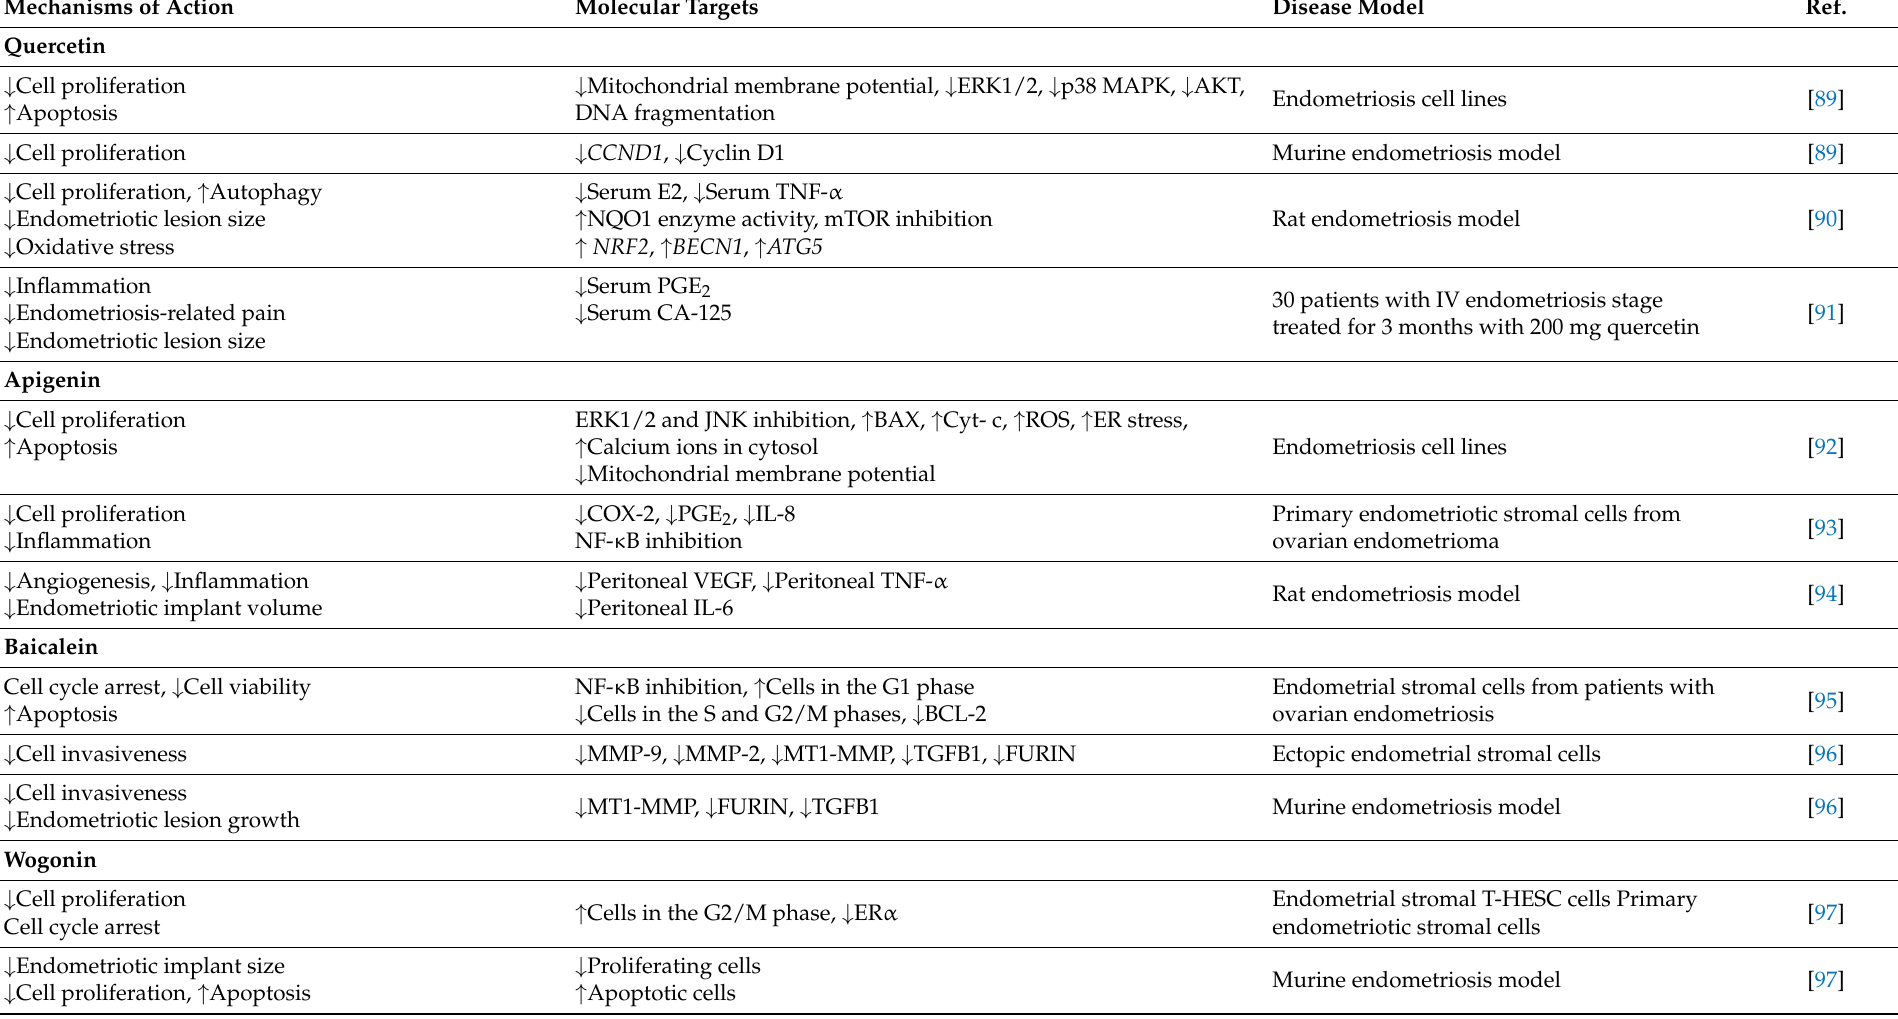
Table 1. Natural polyphenol compounds and their mechanisms of action and molecular targets analyzed in endometriosis preclinical and clinical